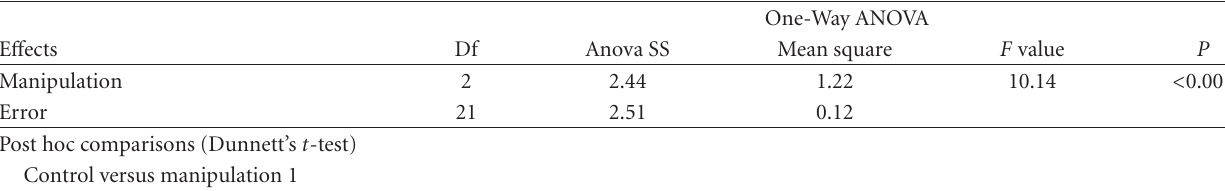
Table 4: One-Way ANOVA results for the removal of females according to the social rank (control: no experimental manipulation, manipulation 1: removal of lower-ranked females, and manipulation 2: removal of higher-ranked females).